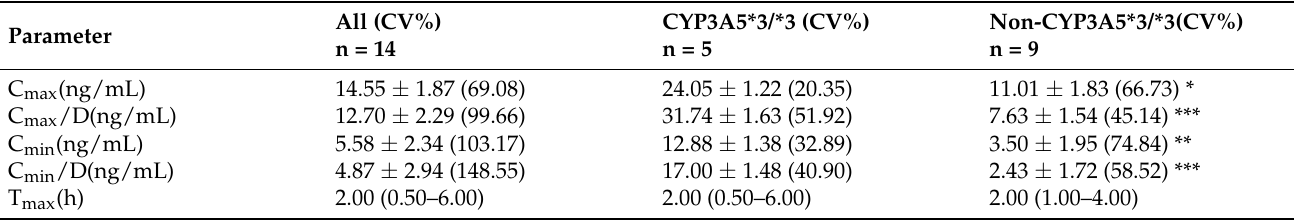
Table 2. Pharmacokinetic parameters of tacrolimus stratified by CYP3A5 genotype.